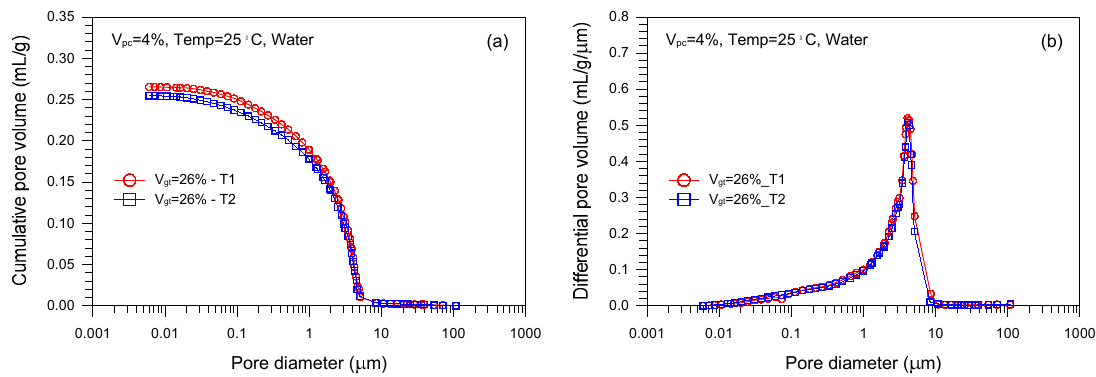
Figure 2. Repeatability of MIP data in identical sample A1: ( a ) cumulative intrusion curve; ( b ) differential instruction curve.